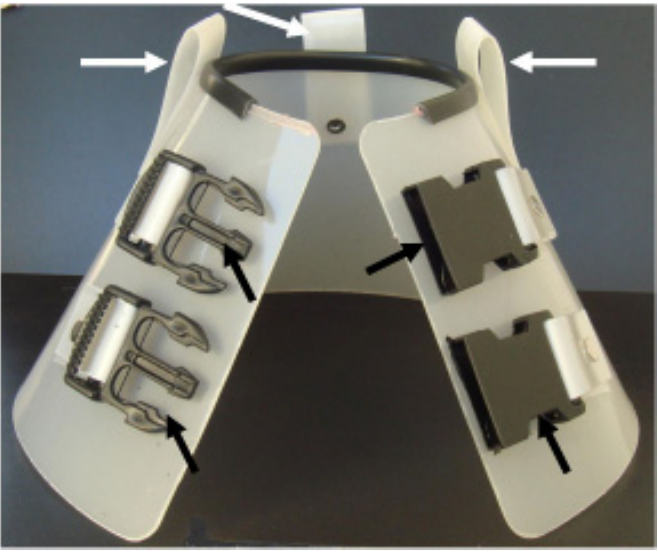
FIGURE 1 – Photograph of an open Elizabethan collar, supported on a flat surface on its anterior side (opening for the animal’s head), showing the fasteners in an open position (black arrows) and straps of the attachment band positioned next to the neck opening of the device (white arrows)